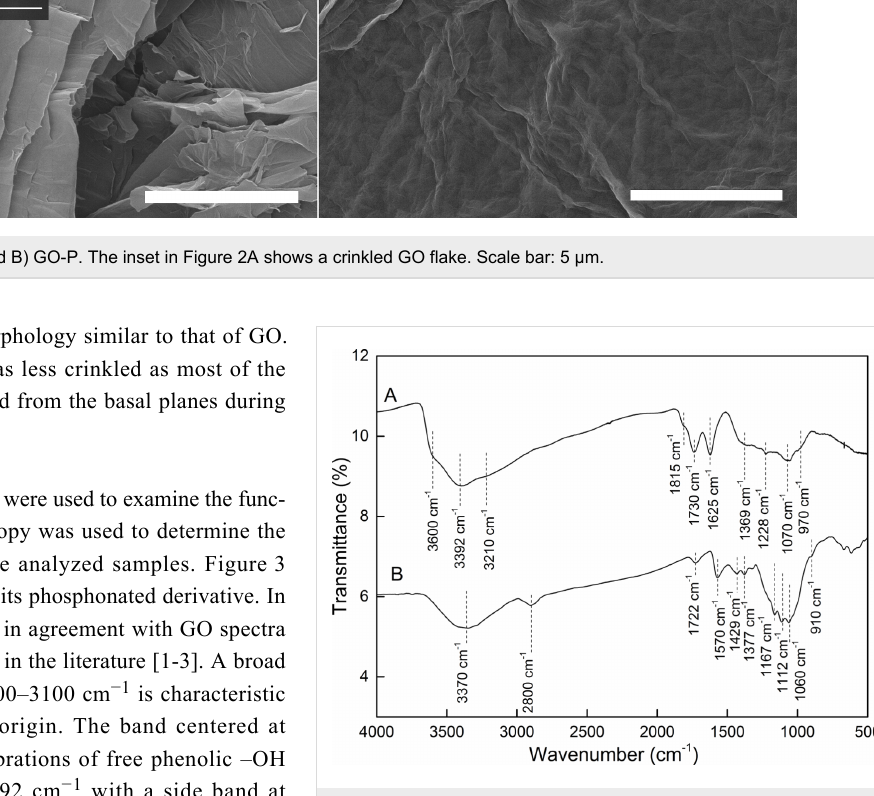
Figure 3: FTIR spectra of A) GO and B) GO-P